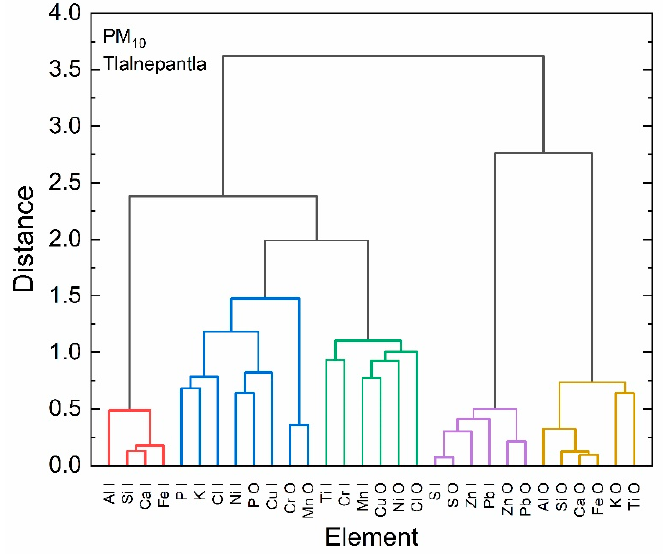
Figure 5. Dendrogram for indoor (I) and outdoor (O) elemental concentrations measured in Tlalnepantla.